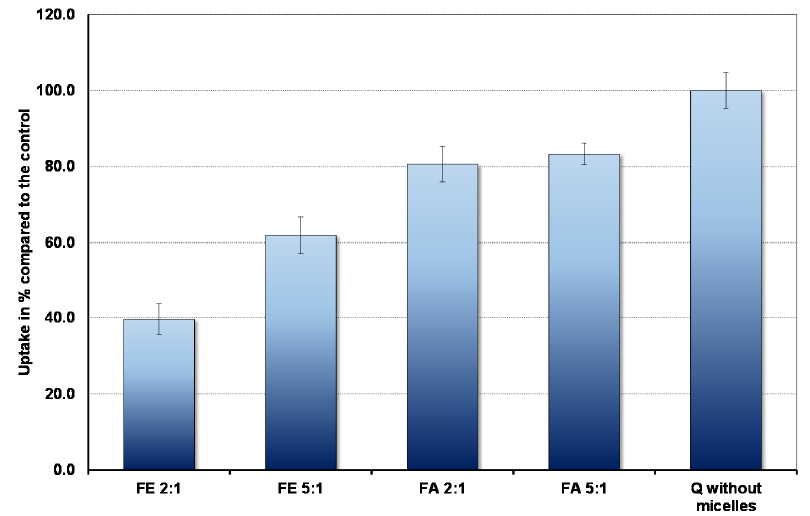
Figure 3 . The amount of quercetin absorbed in 30 min by Caco ‐ 2 cells in the presence and absence of micelles